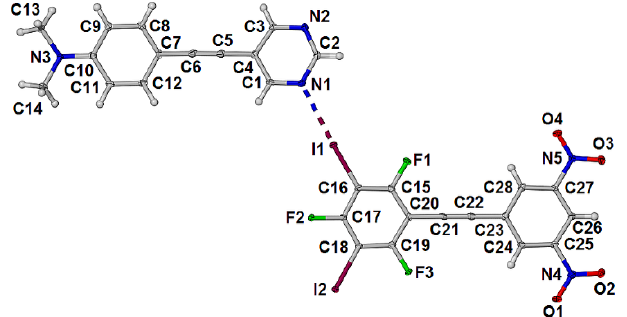
Figure 4. Asymmetric unit of the cocrystal 1•3 with displacement ellipsoids drawn at the 50% level.